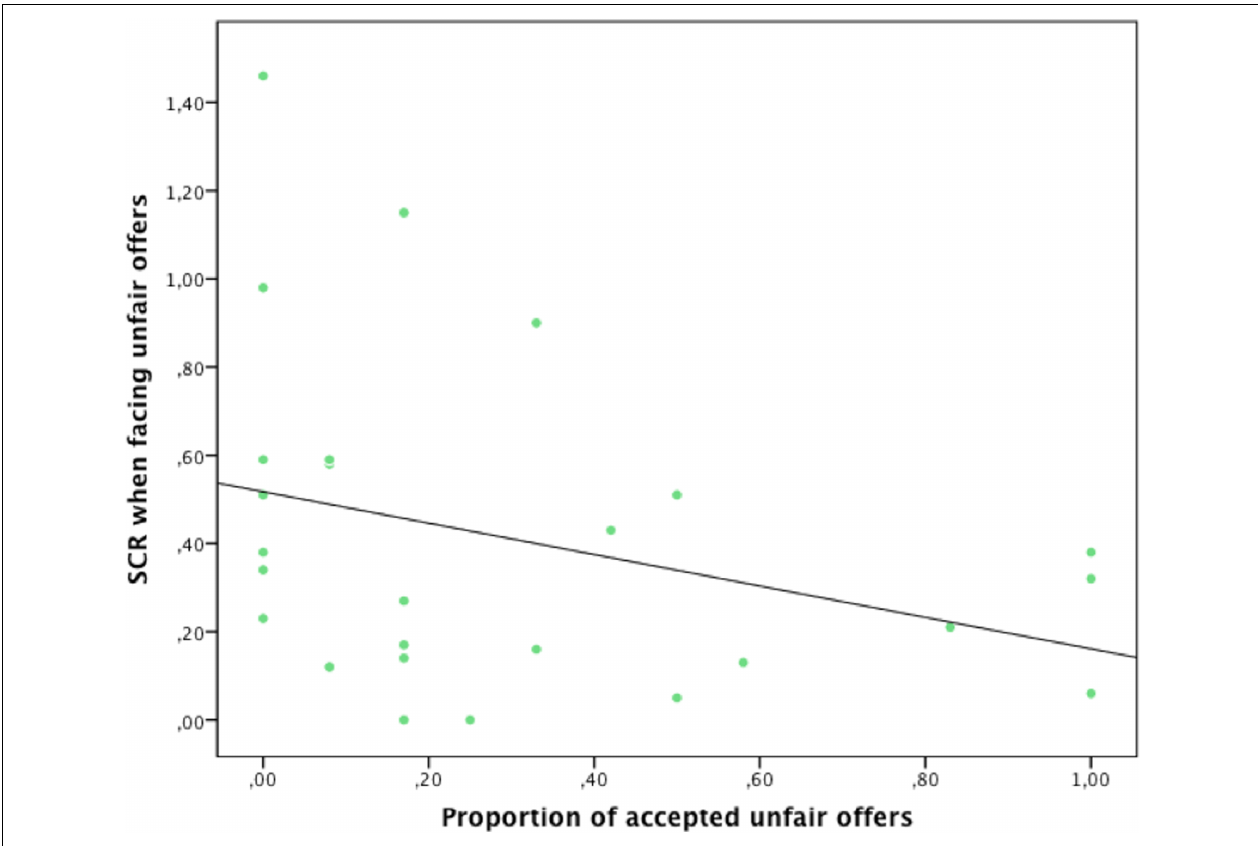
FIGURE 2 | In the alcohol-dependent group ( n = 26), proportion of accepted unfair offers was negatively correlated with SCR amplitude triggered by unfair offers (Spearman Rho = (cid:0) 0.41, p =